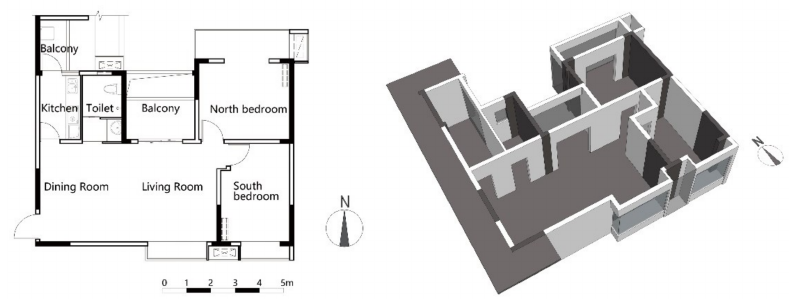
Figure 4. Original floor plan (left) and a perspective view (right) of the residence.